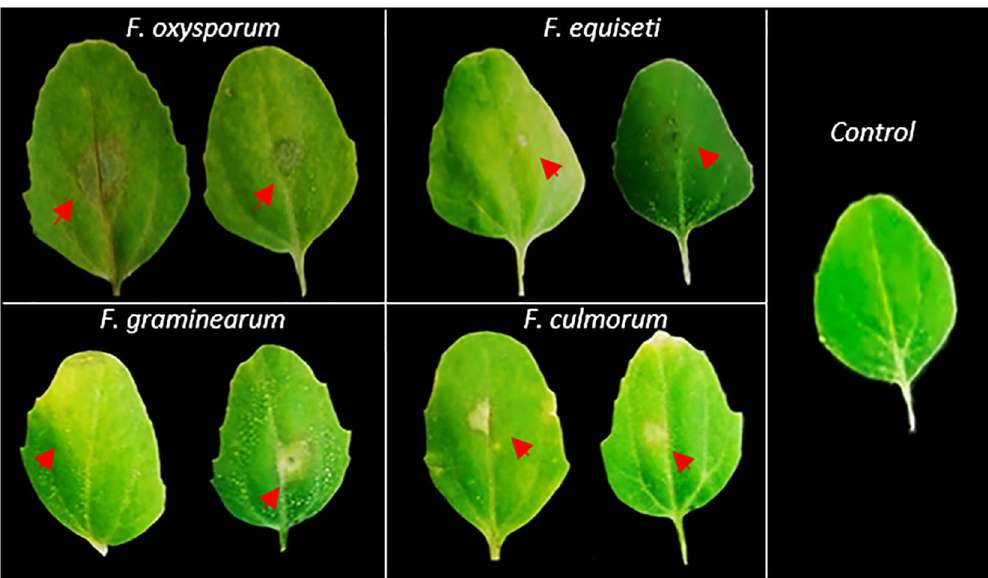
Figure 5. Lesions induced by Fusarium spp. observed in leaves inoculated with isolated mycelia. Chlorotic lesions are observed on leaves incubated in a humid chamber. The photographic record corresponds to after five days post